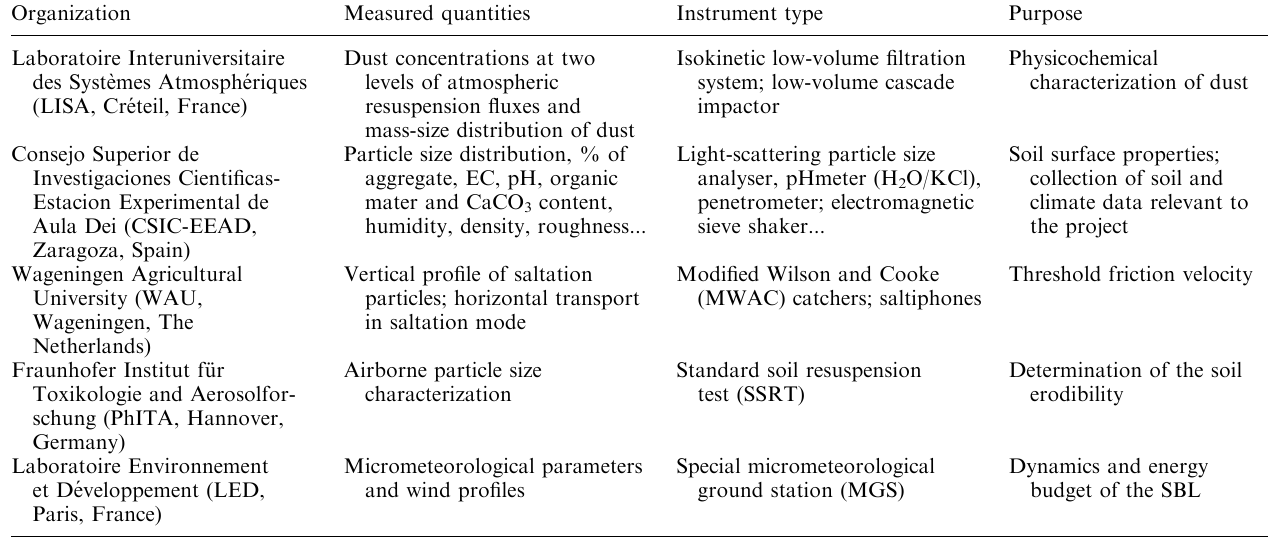
Table 1. Scientific partners and goals in the WELSONS project. The WELSONS experiments were performed by five di(cid:128)erent institutions, experts in atmospheric dust and airborne